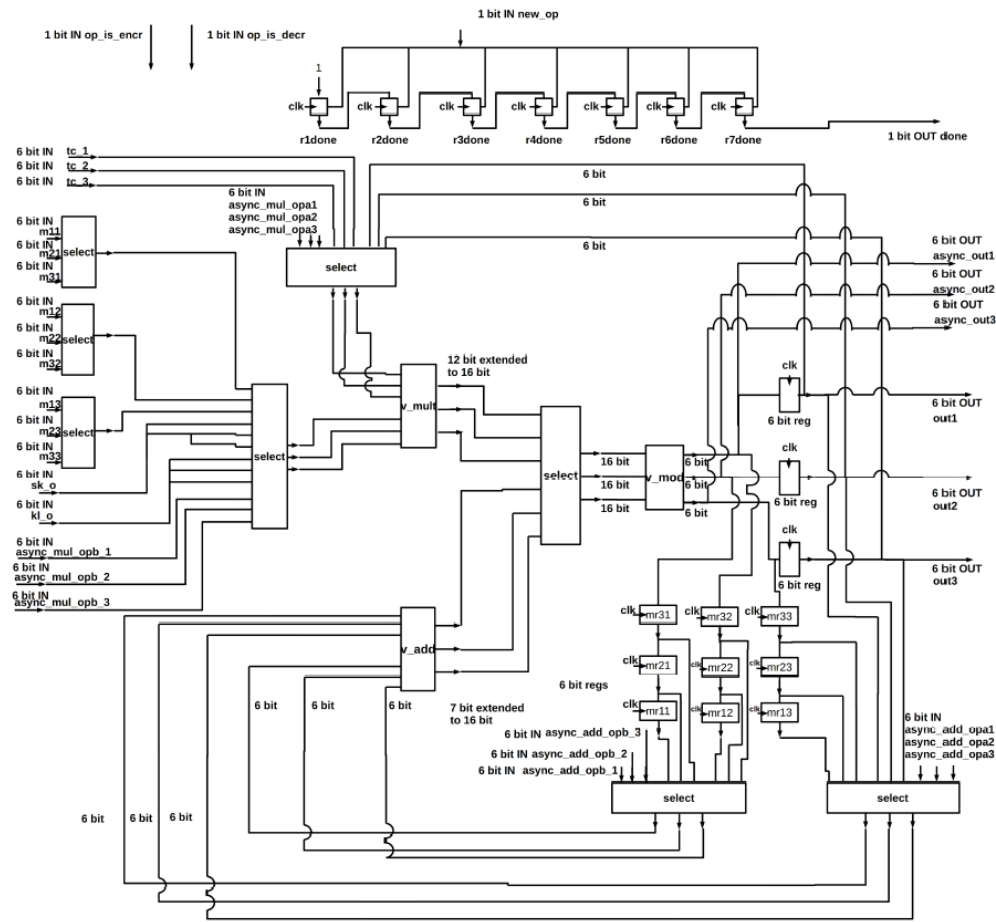
Figure 6. The architecture of the encryption and decryption unit.